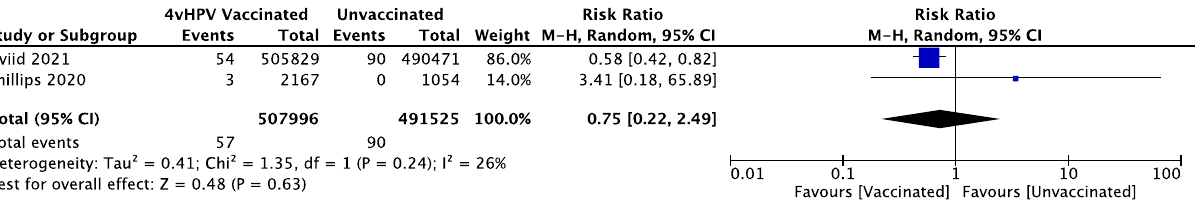
Figure 3. Risk of POI with 4vHPV vaccination relative to no vaccination [15,16]. Relative to 2vHPV and 9vHPV, a similar risk for POI was seen with the 4vHPV vac- cine in the analysis conducted by Gong et al. [17] (RR 0.93 (95% CI 0.33 to 2.64)). On the contrary, Naleway et al. [4] showed a marked reduction of POI risk for 4vHPV relative to the other childhood vaccinations (RR 0.03 (95% CI 0.00 to 0.21)).